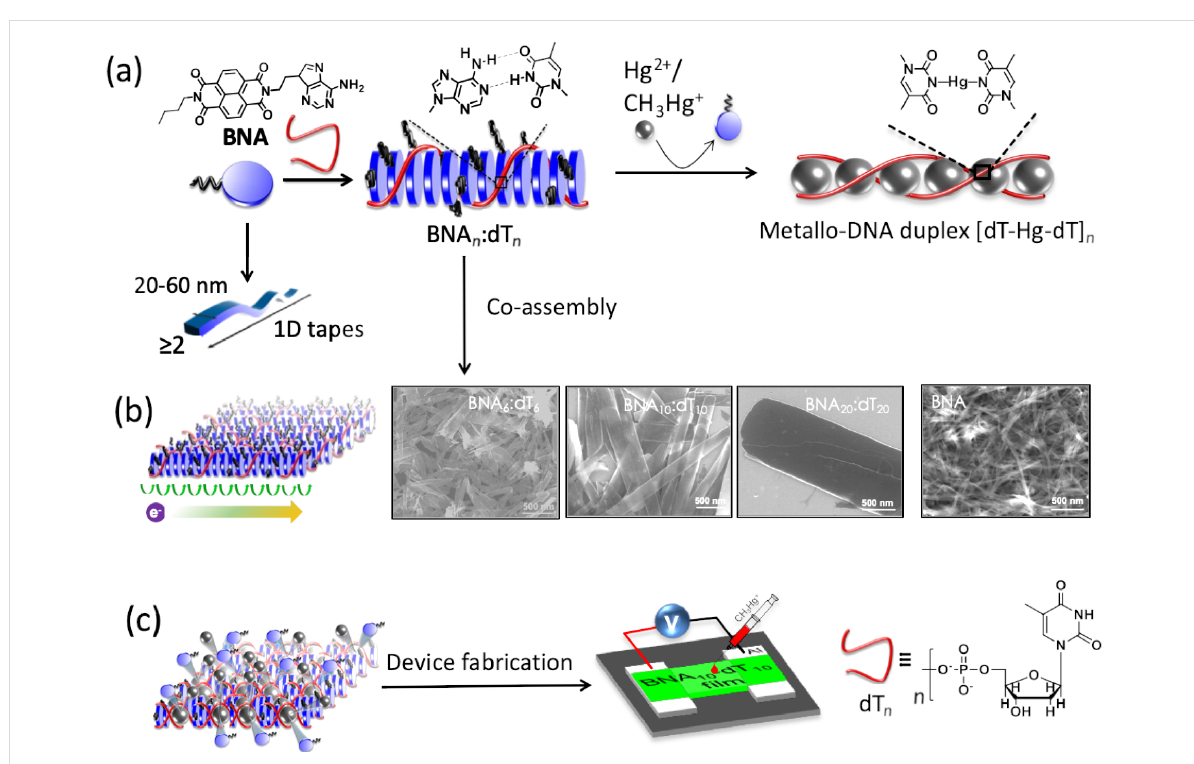
Figure 5: a) Mutually templated coassembly of BNA and dT n ( n = 6, 10, 20) to form a BNA n –dT n hybrid ensemble, and displacement of BNA from Hg(II), followed by the formation of a metallo-DNA duplex. b) FESEM images of 2D nanoarchitectures (nanosheets) of BNA n –dT n coassembly and 1D tapes of BNA. c) Schematic representation of a FET device of BNA n –dT n fabricated for conductometric sensing of Hg(II) with ultrasensitive sensitivity (0.1 nM, 0.02 ppb). Figure 5a–c has been adapted with permission from [20], copyright 2016 American Chemical